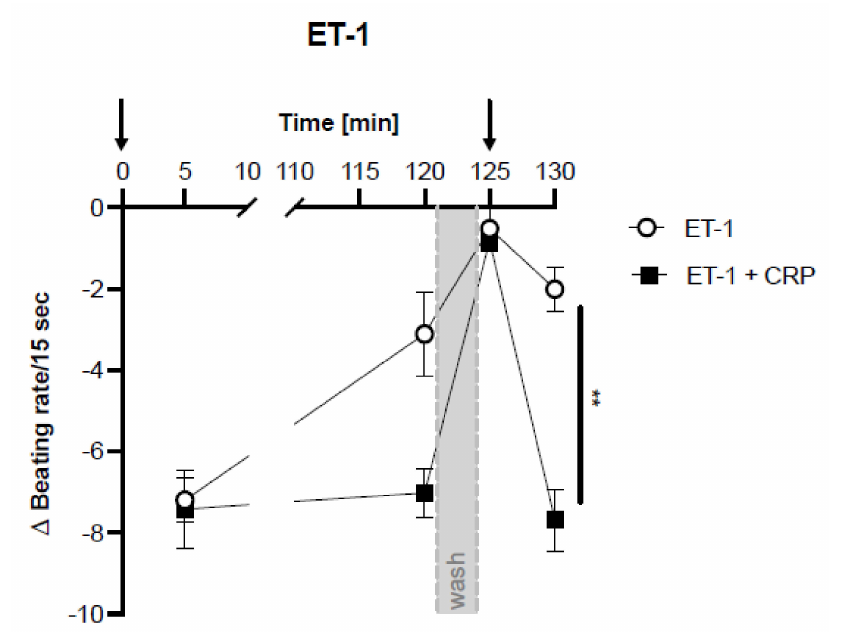
Figure 3. CRP blocks the desensitization of endothelin stimulated neonatal rat cardiomyocytes. Difference of cardiomyocyte beating rates [ ∆ Beating rate/15 s] modulated by endothelin receptor agonist endothelin 1 (ET − 1) with or without CRP co-incubation. ET1 induced a negative chronotropic response. Mean of 4 (control) or 3 (with CRP) independent experiments ± standard deviation is depicted. Arrows indicate stimulation with respective agonists. Grey area indicates washing step. After the washing step, the agonist was added again but no CRP. Significance of difference between CRP incubated and control group at the last time point was calculated with student’s t -test. ** p <